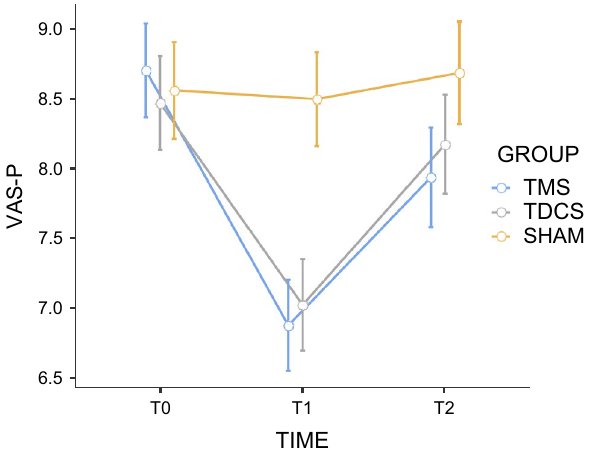
Figure 4. Effects of active repetitive transcranial magnetic stimulation (rTMS), active transcranial direct- current stimulation (tDCS), and sham stimulation on average paroxysmal pain intensity (VAS). The scores were obtained before the first stimulation session (T0), after the 5th consecutive stimulation session (T1) and 30 days after (T2). For the sake of simplicity, and as the effects of sham rTMS and sham tDCS were remarkably similar regardless of the order in which they were conducted, we present the mean values grouped into a single sham- stimulation group. Error bars indicate standard error of the mean. VAS Visual Analogic